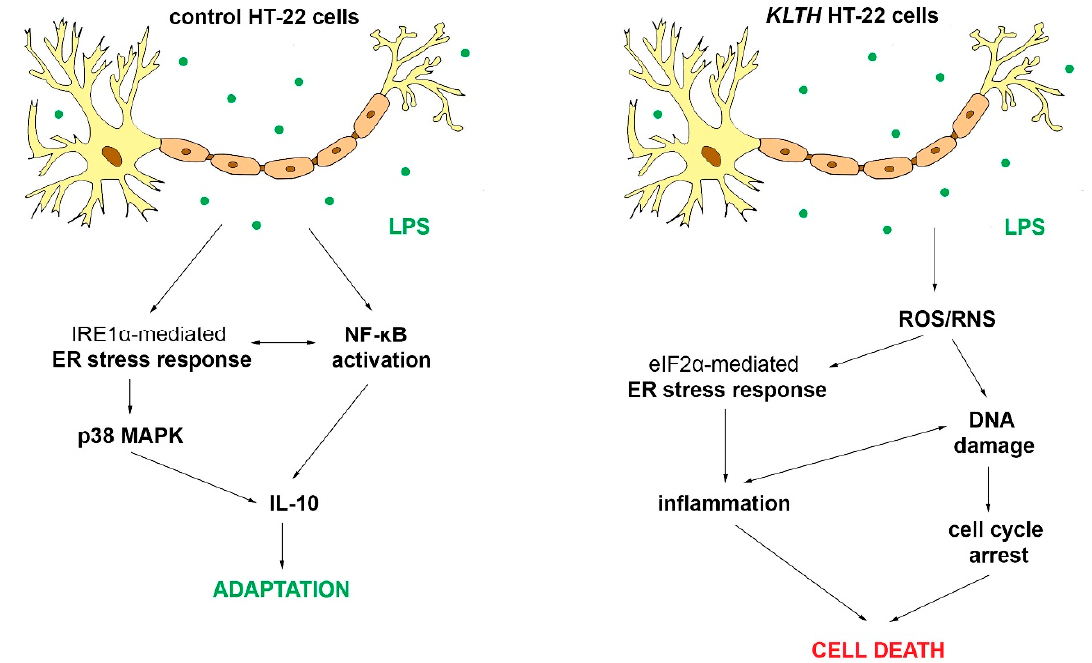
Figure 8. Role of klotho protein in LPS-mediated inflammation in HT-22 hippocampal neuronal cells.